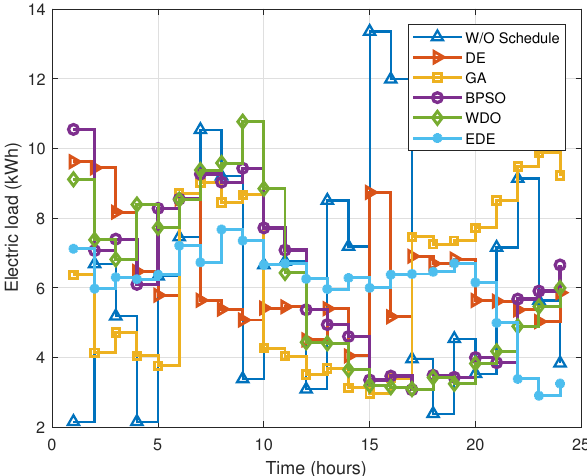
Figure 8. Interruptible appliances energy consumption